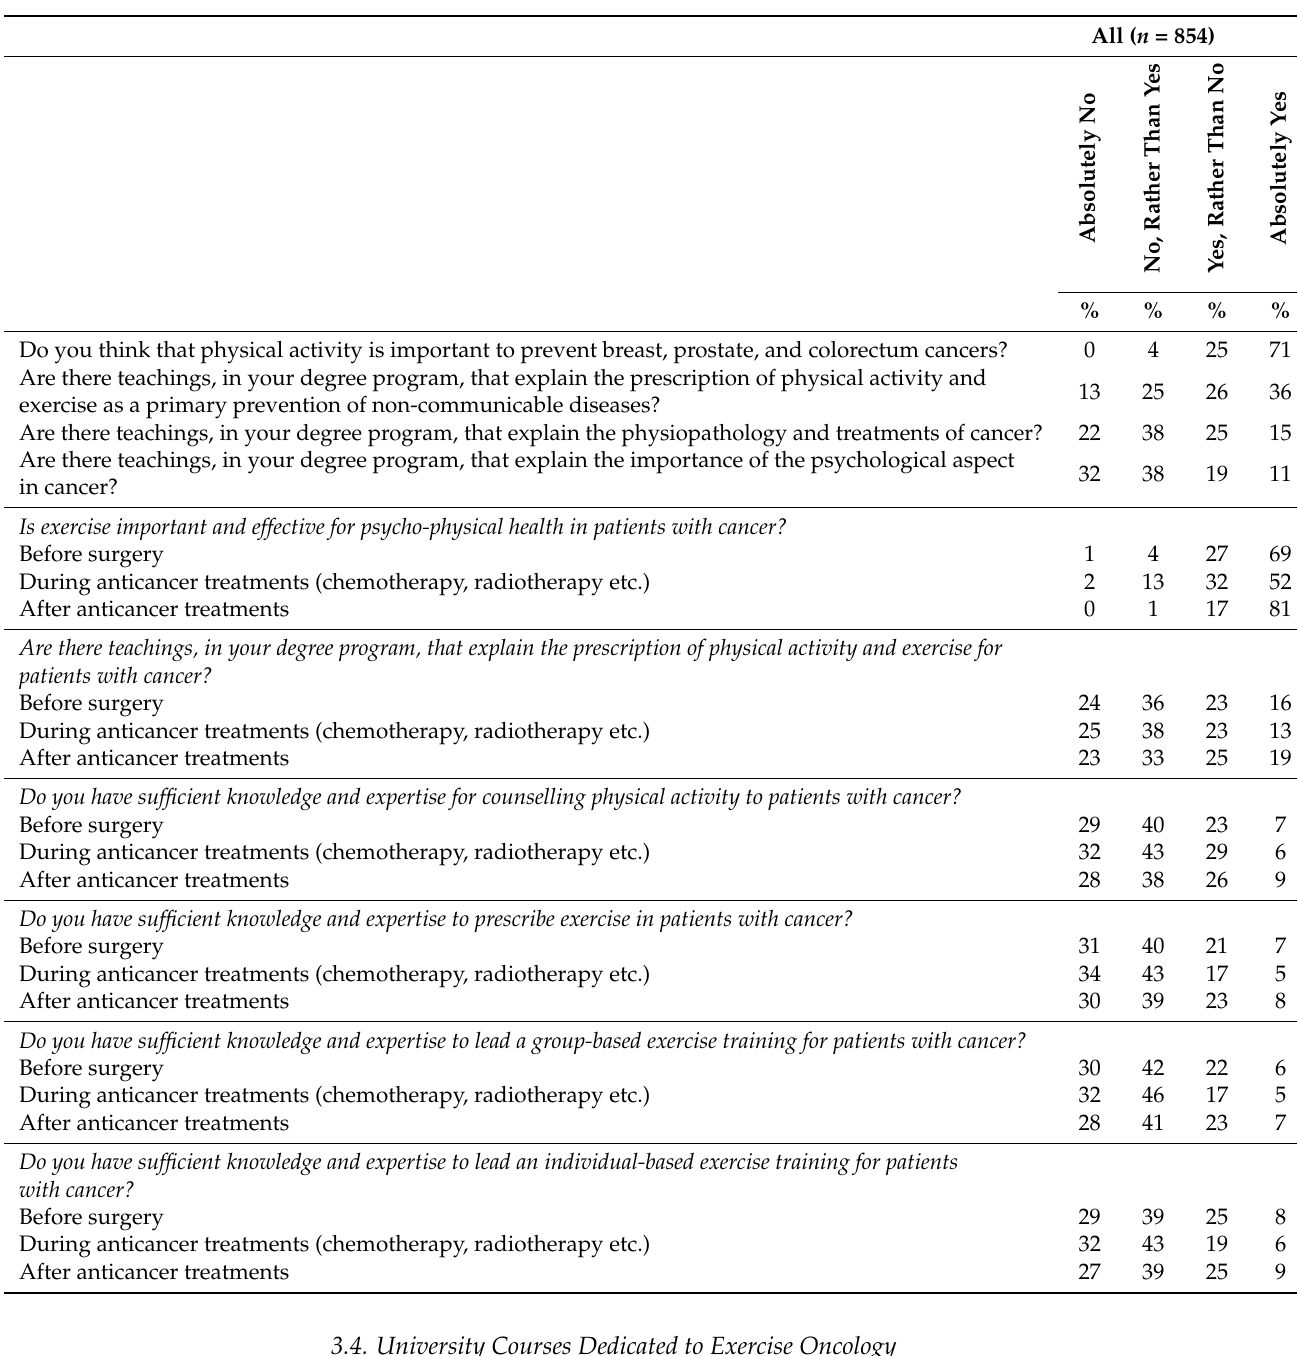
Table 2. Students’ knowledge, perception, and confidence to “exercise